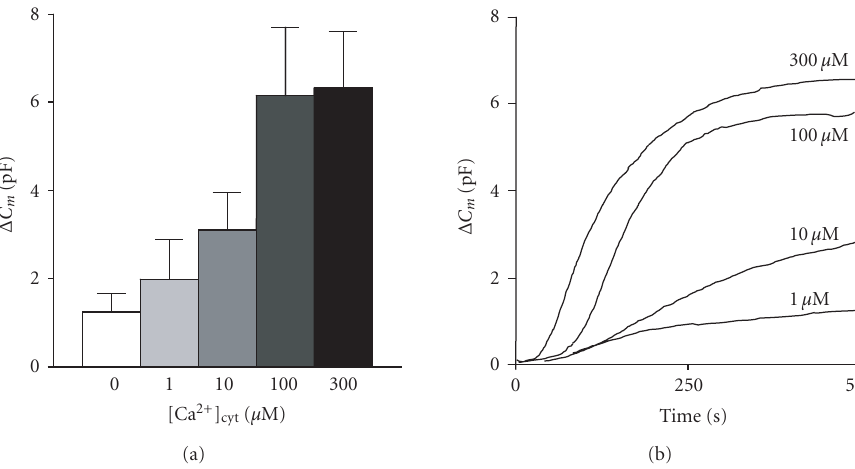
Figure 1: Characteristics of calcium-induced secretion in neutrophils. (a) Change in membrane capacitance induced by increasing con- centrations of [Ca 2+ ] i . Values were determined when a plateau level was reached or 10 min after breakthrough with the patch pipette. (b) Time-course of calcium induced neutrophil exocytosis. The recordings are from representative experiments.